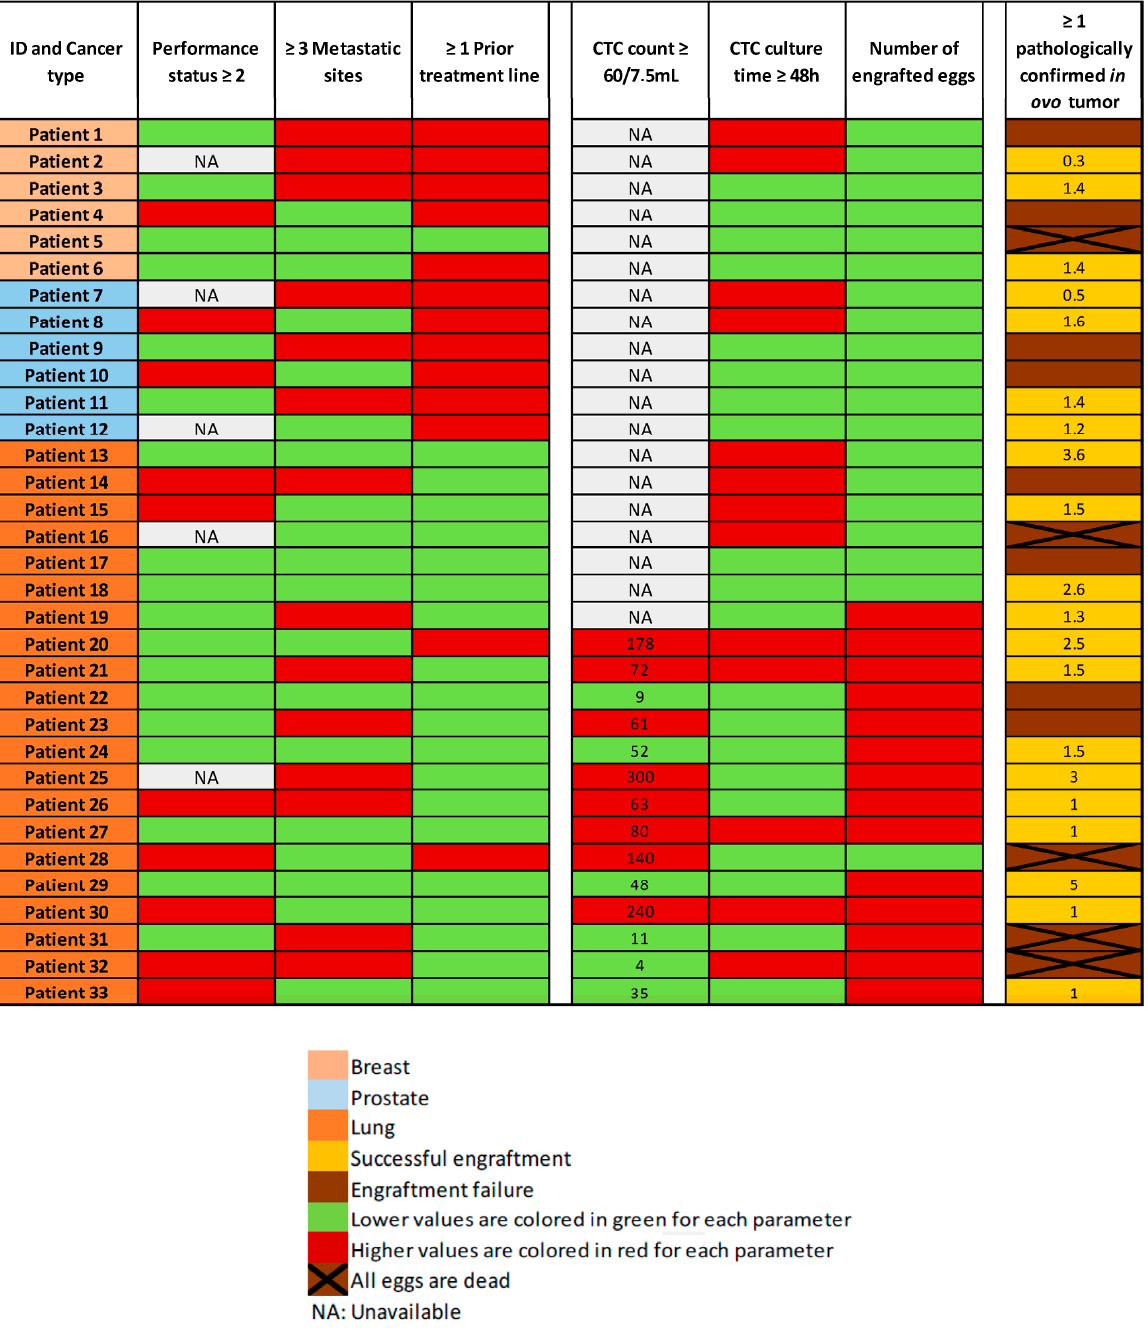
Figure 4. Heatmap of the main clinical characteristics of the patients, CTC counts (with the number of CTCs/7.5 mL of whole blood when available), CTC culture time, and engraftment outcomes (with the tumor diameter in millimeters observed at histopathological analysis, when available).